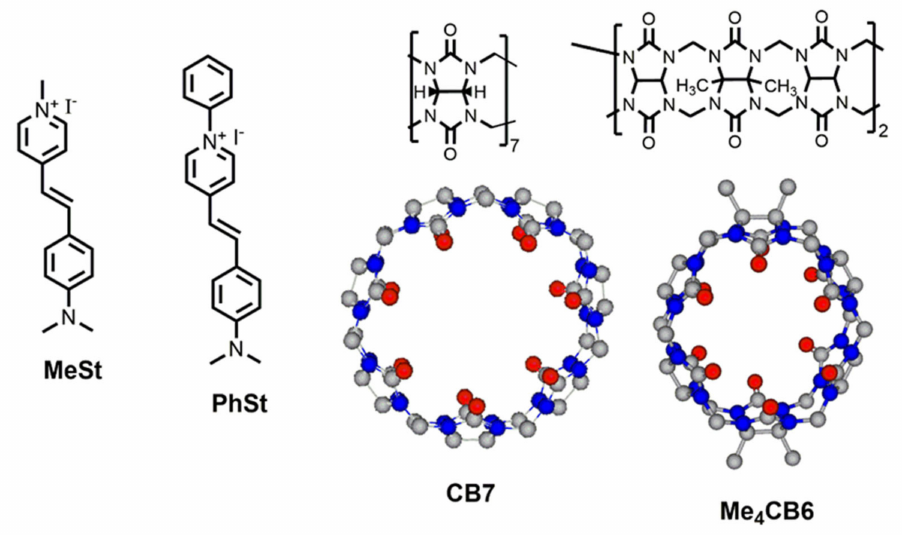
Figure 1. Structures of the indicator dyes MeSt and PhSt and cucurbiturils CB7 and Me 4